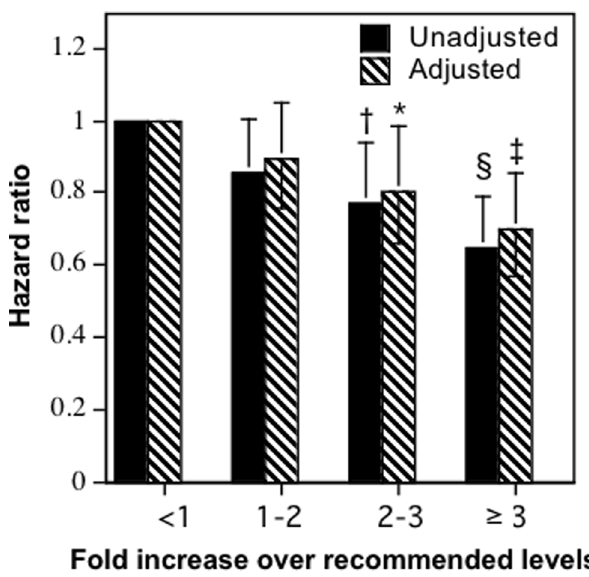
Figure 1. Reduction in the risks for incident cardiac arrhyth- mias per METhr/d for walking and running energy expenditure combined relative to the least active walkers and runners. Adjustment for BMI and hypertension treatment had little effect on these risk reductions. Energy expenditure (X-axis) is categorized in terms of the upper limit of the minimum recommended physical activity levels (750 MET ? min/wk=1.8 METhr/d [10,18]), e.g., 1 to 2-fold higher activity covers from 1.8 to 3.6 METhr/d, 2- to 3-fold covers from 1.6 to 3.4 METhr/d etc. Error bars represent 95% confidence intervals. Significant levels relative to , 1.8 METhr/d coded: * P , 0.05; { P , 0.01, ` P , 0.001, and ` P , 0.0001. The superscript 1 means that the risk for runners who ran $ 3-fold was significantly less than those who ran , 1-fold the recommended level.